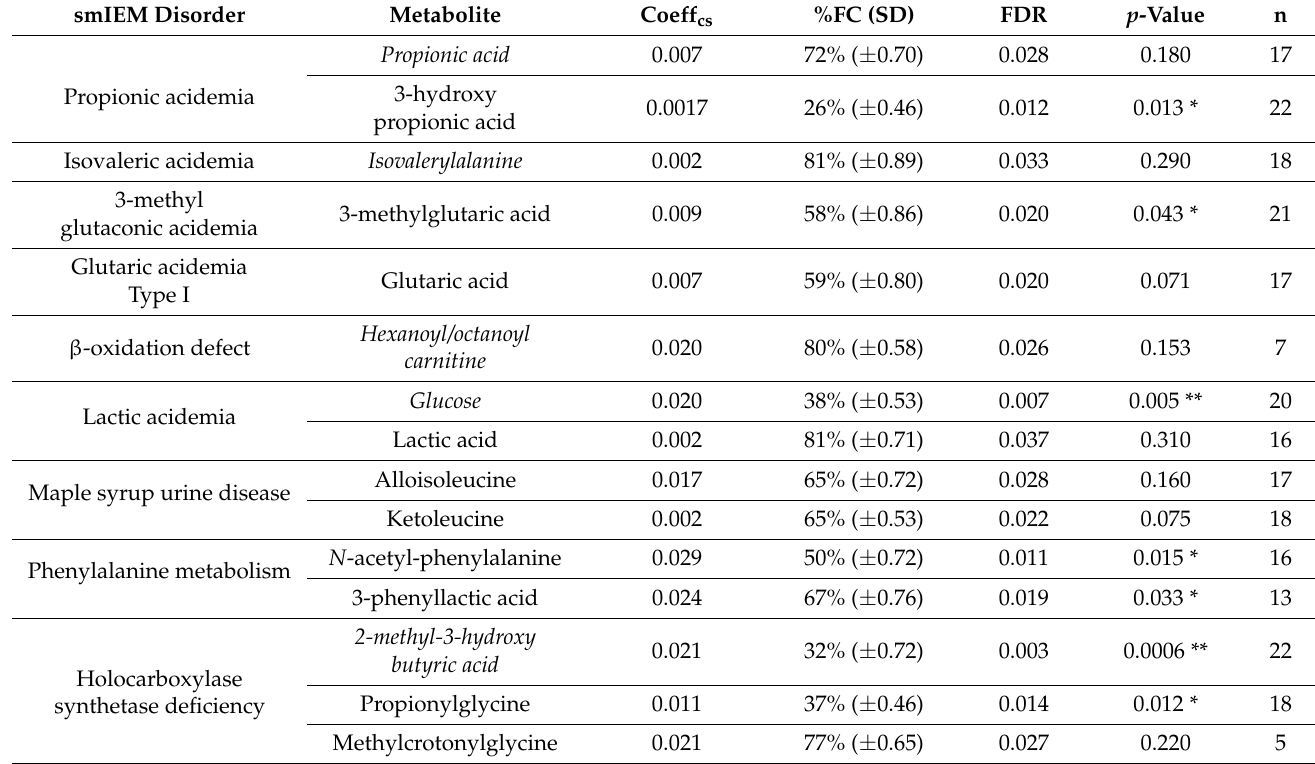
Table 3. Validated biomarker metabolites as potential diagnostic compounds for smIEM